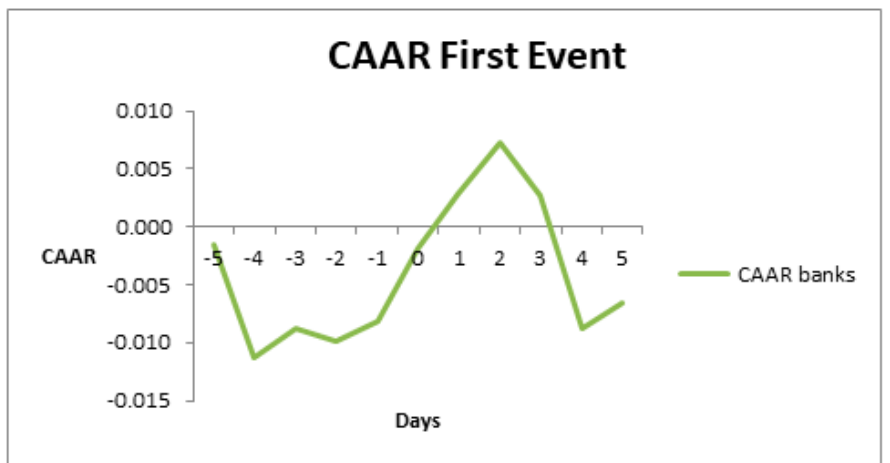
Figure A1. CAARs for banks associated with the first event. Source: Authors’ work.